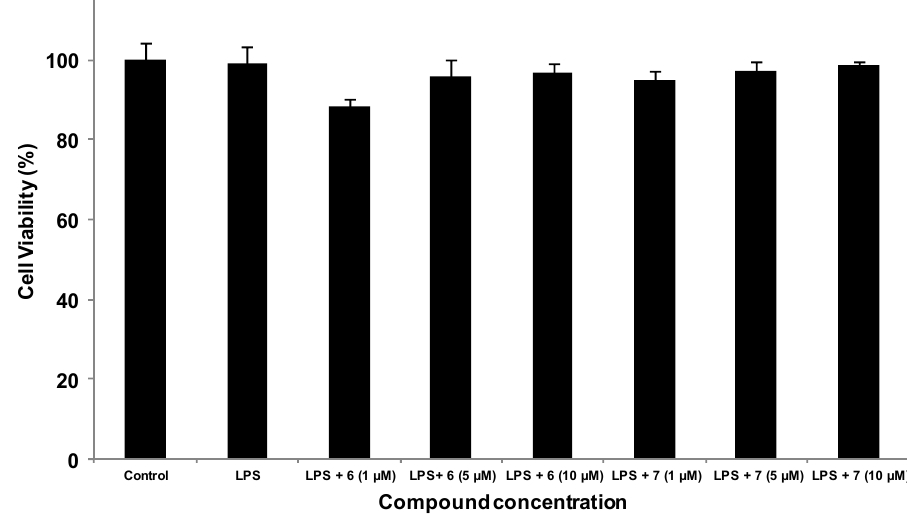
− A ) was measured 550 690